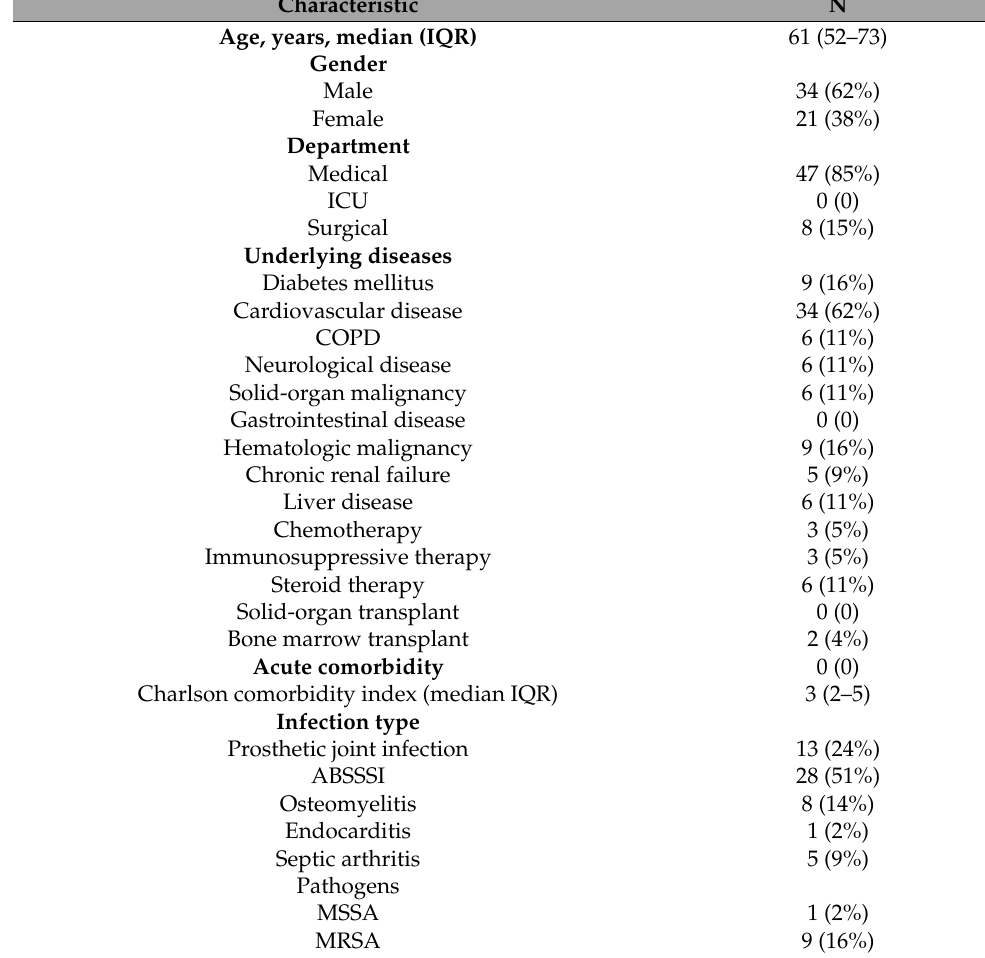
Table 1. Patients’ characteristics involved in the study ( n =